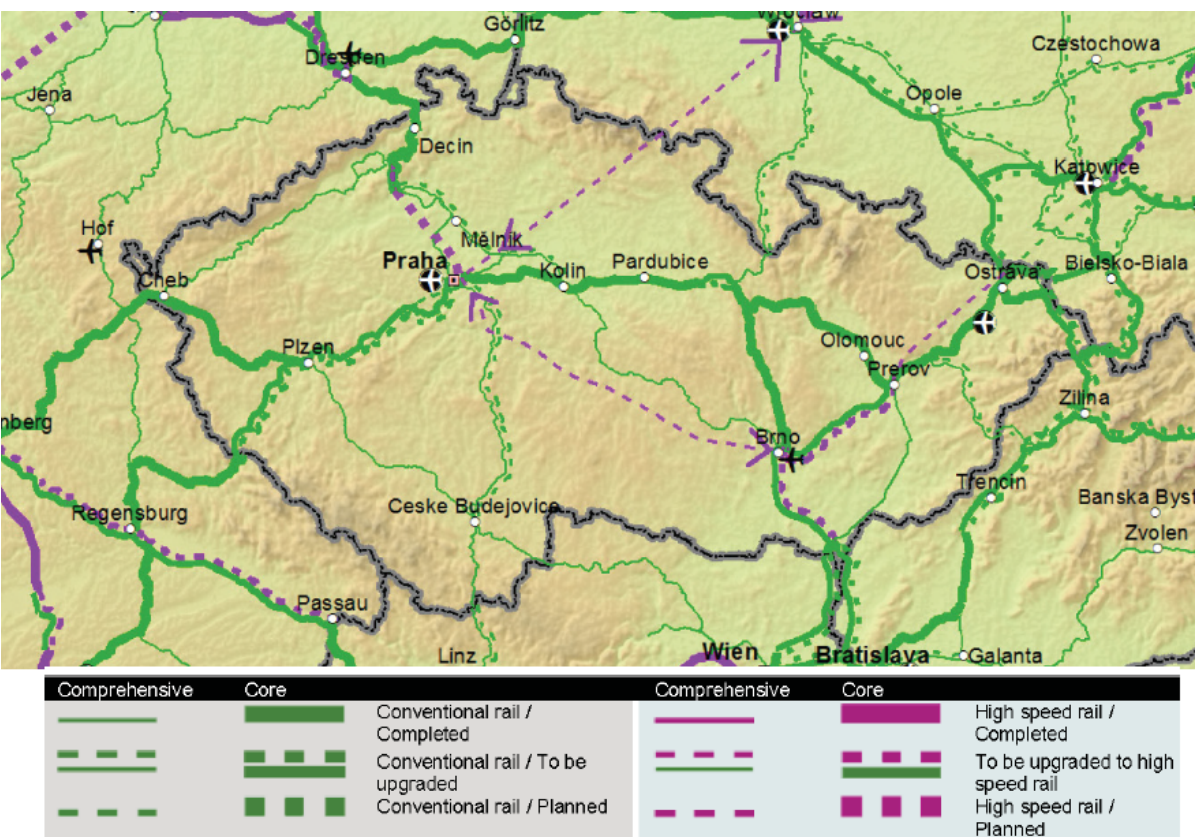
Figure 1. TEN-T map for rail transport